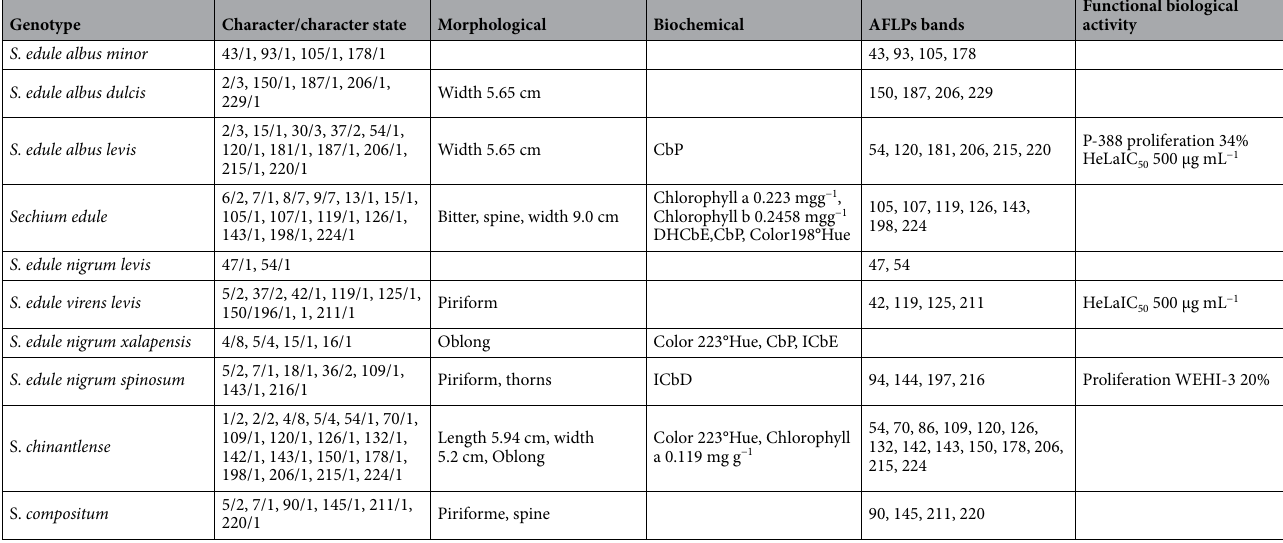
Table 1. Apomorphic characters from the heuristic clade with morphological, biochemical, and genetic variables in ten genotypes of Sechium spp. The diagonal indicates the character and the relevant state of the character.